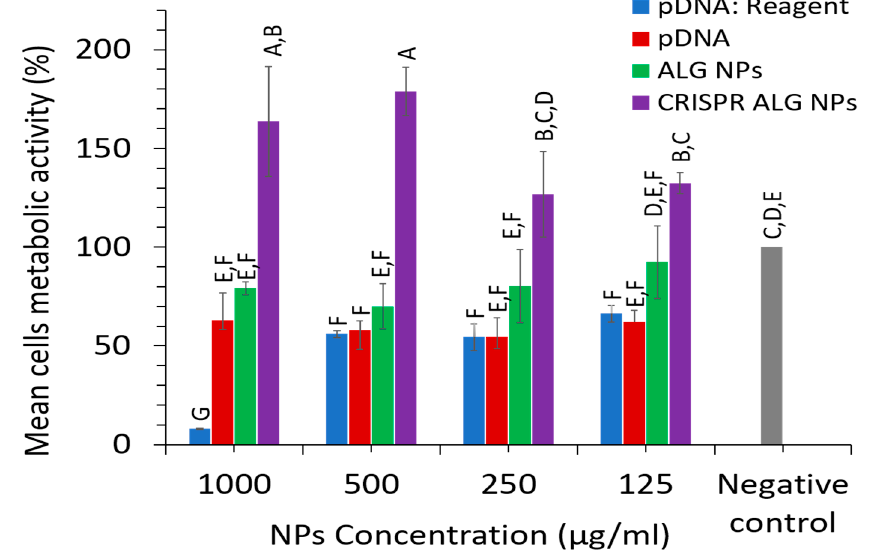
Figure 8. Viability of HepG2 cells 48 h post-transfection (mean ± SD; n = 3). pDNA: ALG ratio 1:10. Concentration of pDNA is equivalent to the concentration of pDNA in NPs. pDNA: NanoJuice transfection reagent ratio 1:2.5. Statistical significance of results was determined using Tukey’s Multiple Comparison Test. Letter denotes significance, whereby groups that do not share a letter are significantly different p < 0.05 ( n = 3).